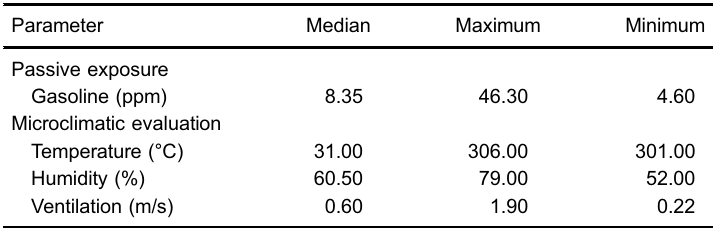
Table 2. Passive exposure to solvents and microclimatic evaluations during 7 h of activity in the 20-day period.